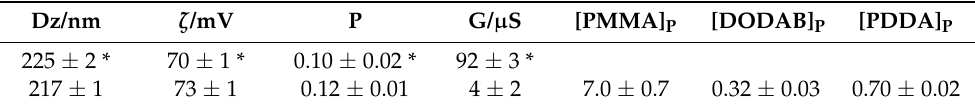
Table 2. Properties and composition of PMMA/DODAB/PDDA NPs: mean hydrodynamic diameter (Dz), zeta-potential ( ζ ), polydispersity (P), and conductance (G) after dialysis or after removal of free cationic components. Subscript P indicates concentration in NPs; asterisk indicates data for non-treated NPs after dialysis. Concentrations are given in mg mL − 1